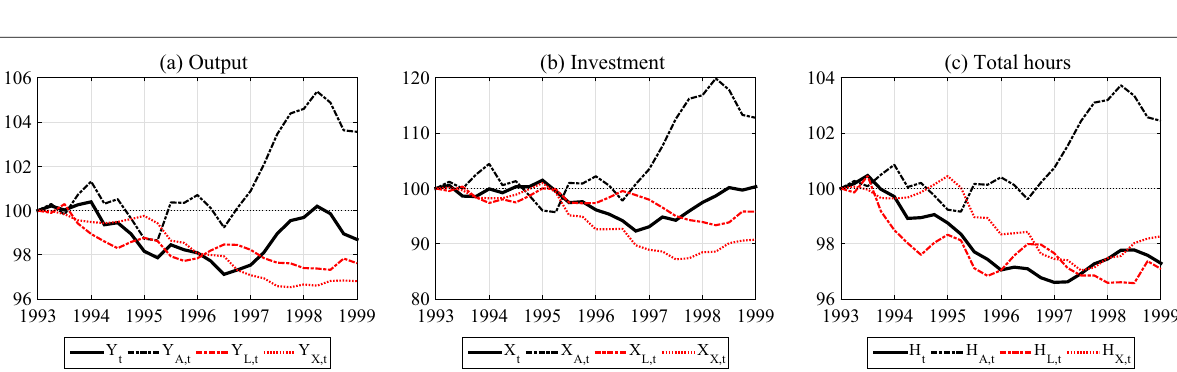
Fig. 13 Robustness: The 1993Q1–1999Q1 period for ν = 0.5 . The subscripts A , L , X denote the efficiency-, labour-, and investment-wedge-alone components of output Y t , investment X t , or total hours H t